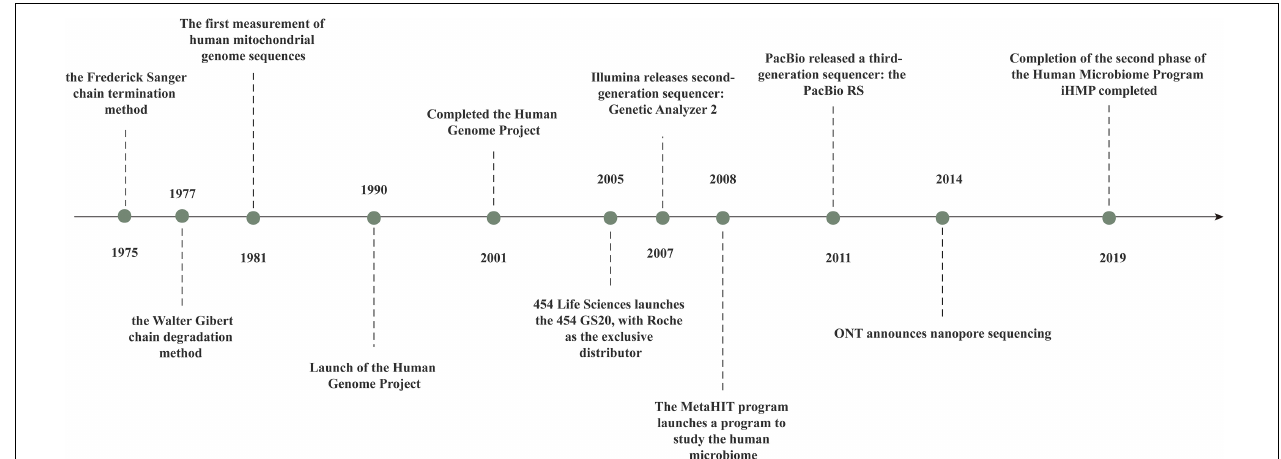
FIGURE 2 | The history of gene